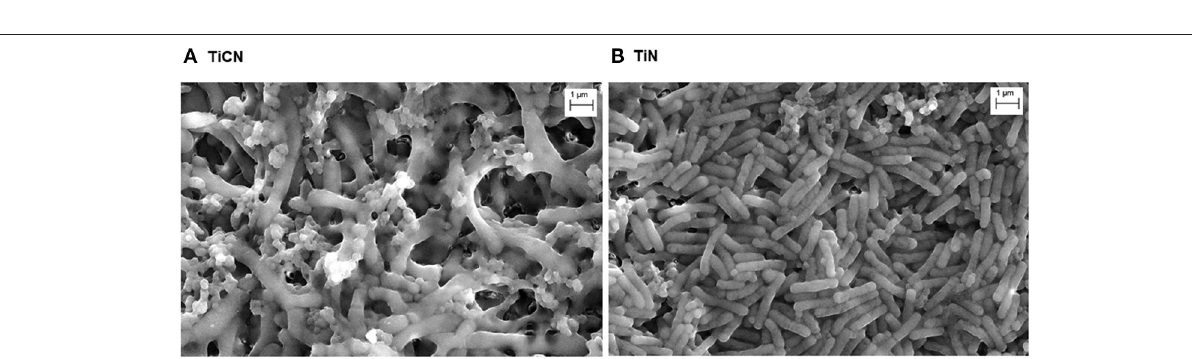
Frontiers in Dental Medicine |